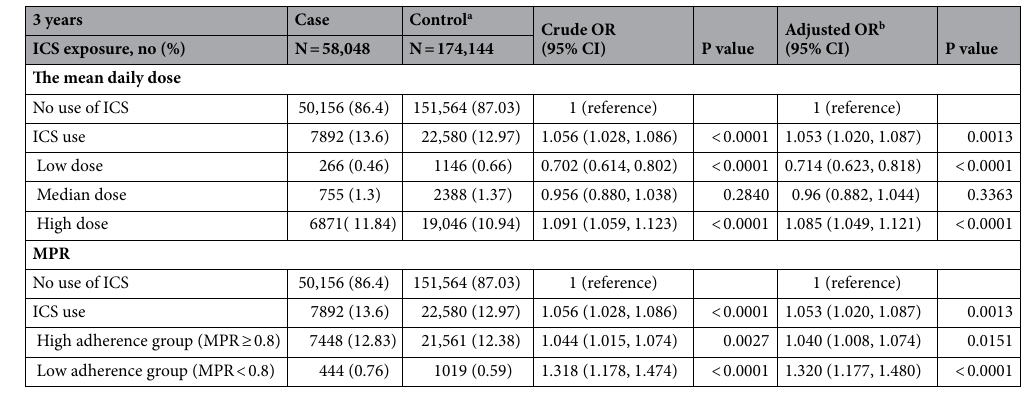
Table 3. Risk of osteoporosis with use of ICS, stratified by the mean daily dose, and MPR of ICS. OR odds ratio. a Case and control matched by age group, gender, COPD severity, asthma, dyslipidemia, hypertension, diabetes mellitus, chronic kidney disease, chronic liver disease, and malignancy. b Adjusted for age group, gender, urbanization level, income, COPD severity, comorbidity, the oral steroids use and co-medication.